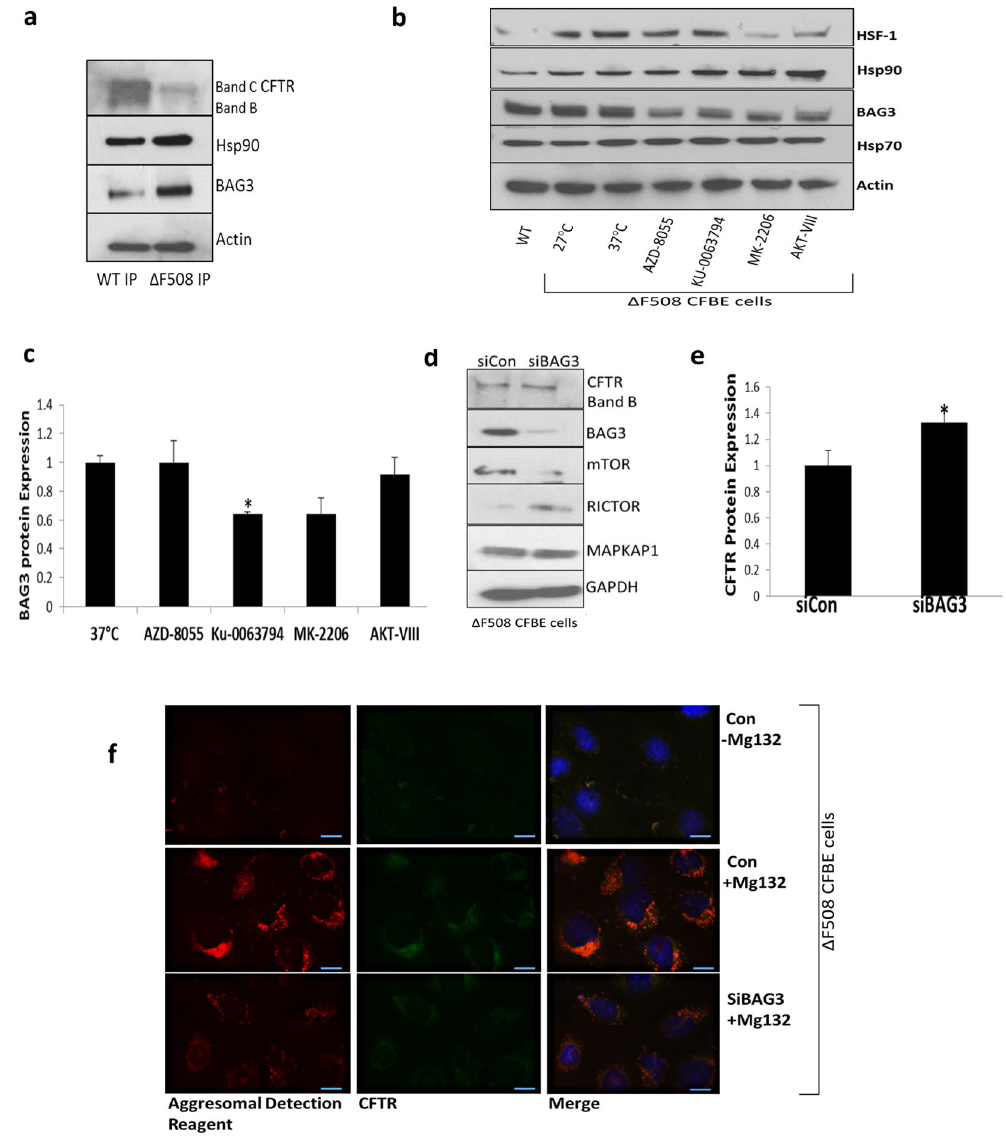
Figure 5. PI3K/AKT/mTOR inhibition increases Δ F508 CFTR stability through BAG3. ( a ) CFTR was immunoprecipitated from WT HBE41o- and Δ F508 CFBE41o- cells and immunoblotting was performed for Hsp90, BAG3 and β -actin . (b ) Δ F508 CFBE41o- cells (37 °C) were treated with AZD-8055, KU-0063794, AKT- VIII and MK-2206 and the protein expression of Hsp70, Hsp90, BAG3 and HSF1 and actin was determined. WT HBE41o- cells and Δ F508 CFBE41o- cells (27 °C) acted as positive controls and Δ F508 CFBE41o- (37 °C) was a benchmark for comparison ( c) A quantitative graph of BAG3 from Δ F508 CFBE41o- lysates, CFBE41o- cells (37 °C) were treated with AZD-8055, KU-0063794, AKT-VIII and MK-2206. The results shown are representative of three independent experiments; the histograms represent the average and the error bars represent the standard deviation of the means. Statistical significance was examined using a two tailed by paired T-test analysis. Asterisk * represents p ≤ 0.05 ( d ) Protein expression levels of CFTR, mTOR, RICTOR, MAPKAP1 and BAG3 were determined by immunoblotting in Δ F508 CFBE41o- cell lysates treated with control and BAG3 siRNA. ( e ) A quantitative graph of CFTR from Δ F508 CFBE41o- cell lysates treated with control (siCon) and BAG3 siRNA (siBAG3) was performed. Statistical significance was examined using a two-tailed paired T-test analysis. Asterisk * represents p < 0.05. ( f) Fluorescent detection was used to visualise CFTR (green- 488 nm) and aggresomes (red- 549 nm) in Δ F508 CFBE41o- cells treated and untreated with proteasome inhibitor MG132 (10 µ M) to validate the presence of aggresomes in these cells after MG132 treatment. Aggresome fromation in Δ F508 CFBE cells in the presence of siBAG3 relative to siControl under proteasomal inhibiton was then investigated. Nuclei were stained with DAPI (blue- 358